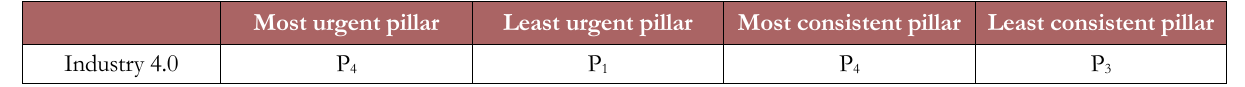
Table 21. Descriptive statistics of pillars at the organization level.